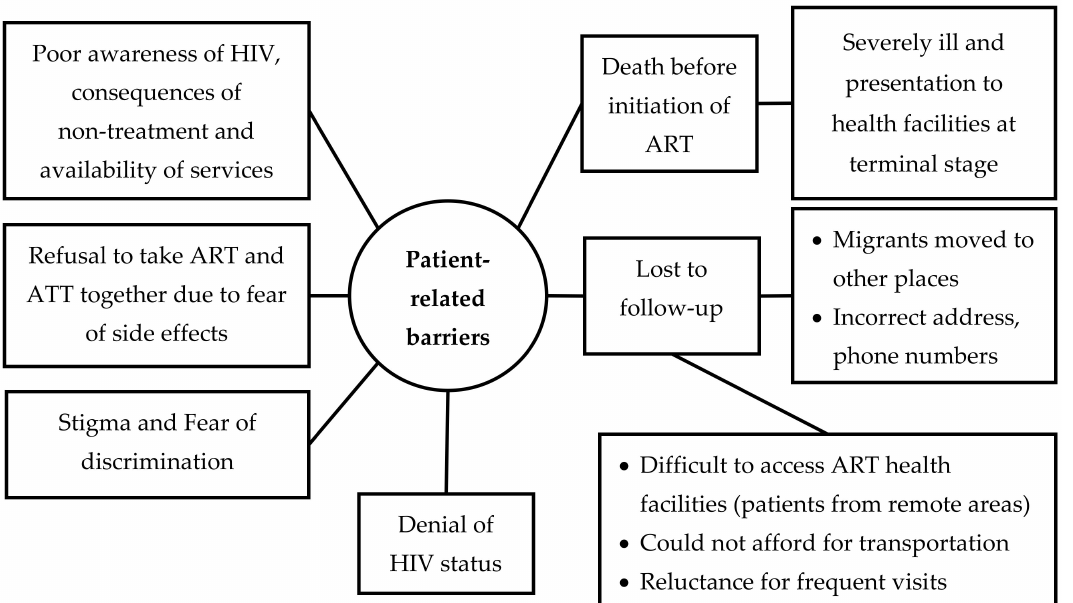
Figure 2. Non-hierarchical thematic map showing patient-related barriers in uptake of antiretroviral therapy among HIV-infected tuberculosis patients registered in the public health facilities of Ayeyawady Region of Myanmar, between July 2017 and June 2018.